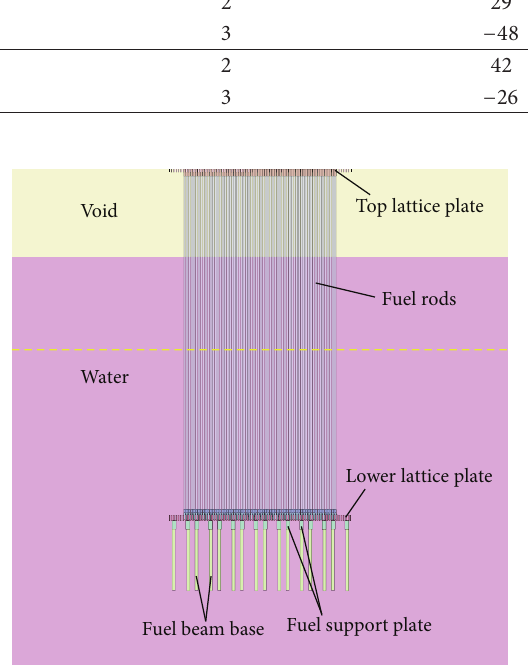
Figure 3: Axial view of DIMPLE